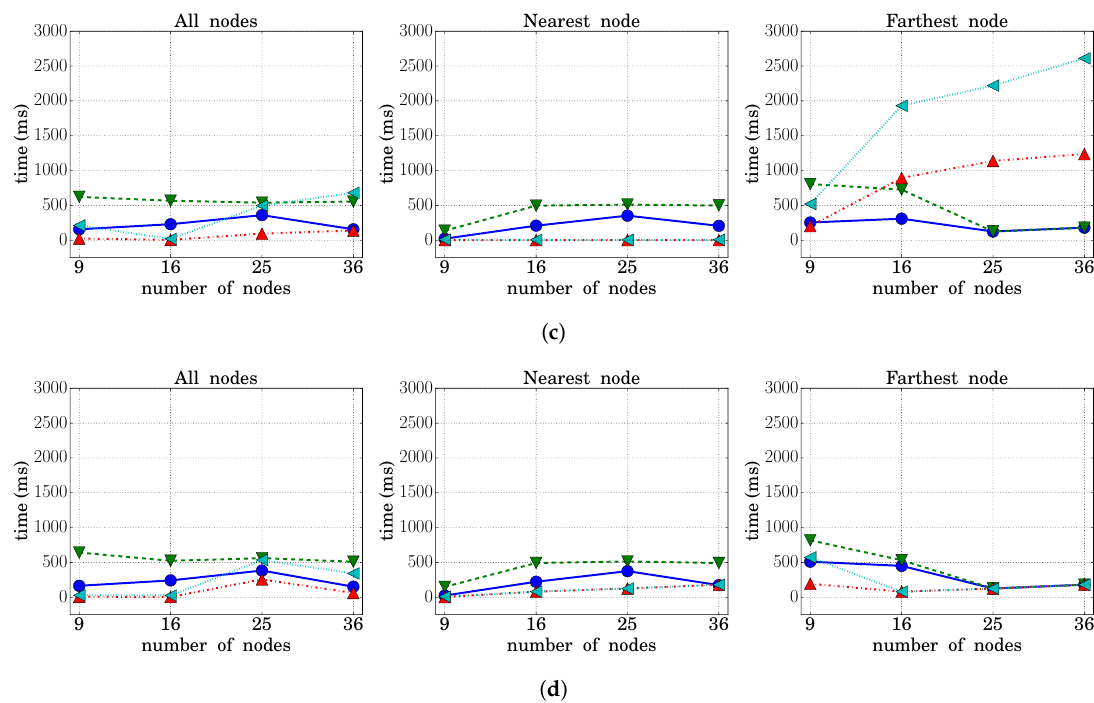
Figure 9. Network transit time (HWMP vs. MPC-HWMP). ( a ) Traffic Type 1; ( b ) Traffic Type 2; ( c ) Traffic Type 3; ( d ) Traffic Type 4.